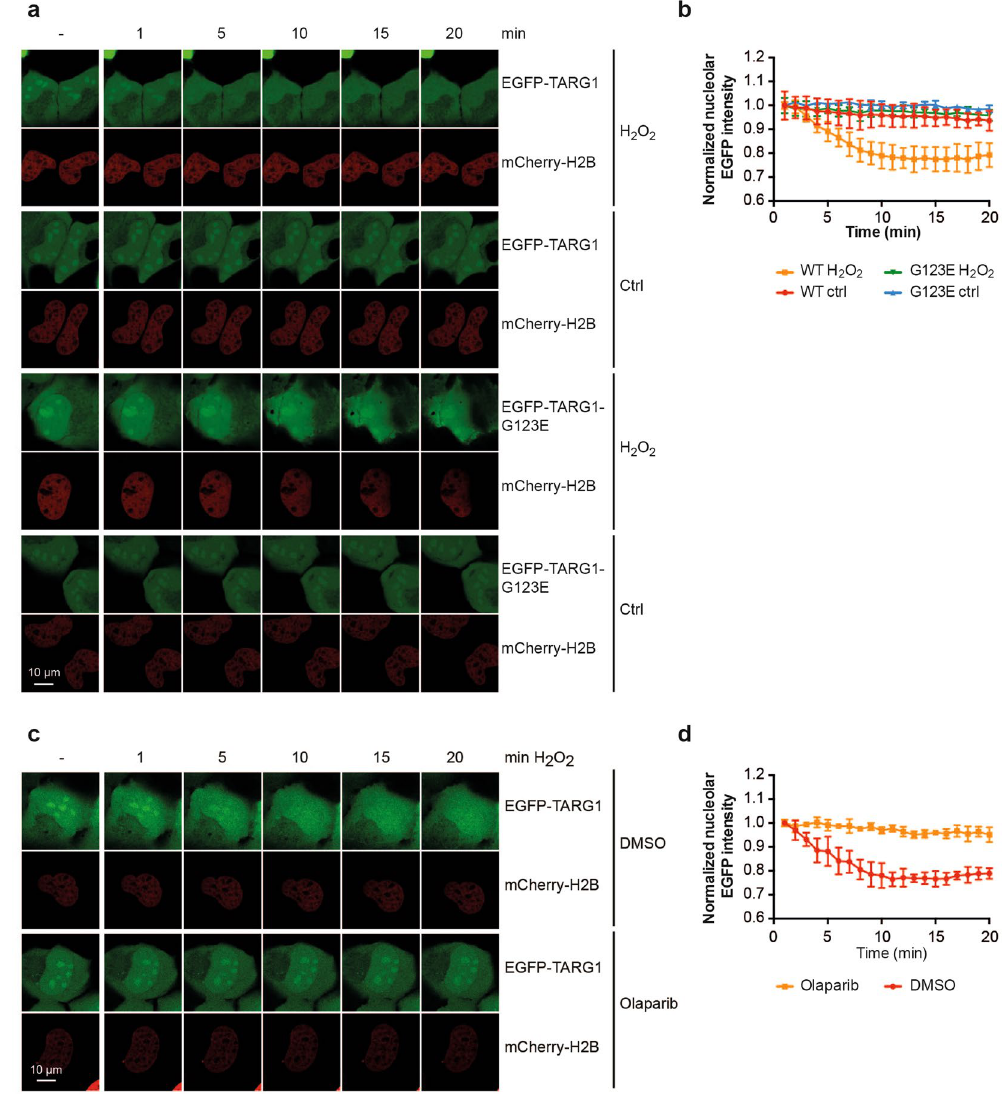
Figure 5. Nucleolar accumulation of TARG1 is lost upon H 2 O 2 -treatment. ( a ) U2OS cells transiently expressing EGFP-TARG1 or EGFP-TARG1-G123E together with mCherry-H2B were or were not (ctrl) treated with 1 mM H 2 O 2 . Subcellular localization of EGFP-TARG1 (wildtype/G123E) before ( − ) and during the first 20 min after treatment was analyzed in living cells by confocal microscopy. A representative experiment is depicted. ( b ) Quantifications of nucleolar EGFP intensities from cells imaged during the experiment depicted in panel A are given. Nucleolar EGFP-intensities were measured using ImageJ, normalized to nuclear EGFP-intensities at each time point and to the normalized nucleolar EGFP intensity 1 min after treatment (mean ± SD of at least 3 cells). ( c ) U2OS cells transiently expressing EGFP-TARG1 wildtype together with mCherry-H2B were treated with DMSO or 10 µ M olaparib for 2 h before treatment with 1 mM H 2 O 2 . Subcellular localization of EGFP-TARG1 before ( − ) and during the first 20 min after treatment was analyzed in living cells by confocal microscopy. A representative experiment is depicted. ( d ) Quantifications of nucleolar EGFP intensities from cells imaged during the experiment depicted in panel c are given. Intensities were calculated as in panel